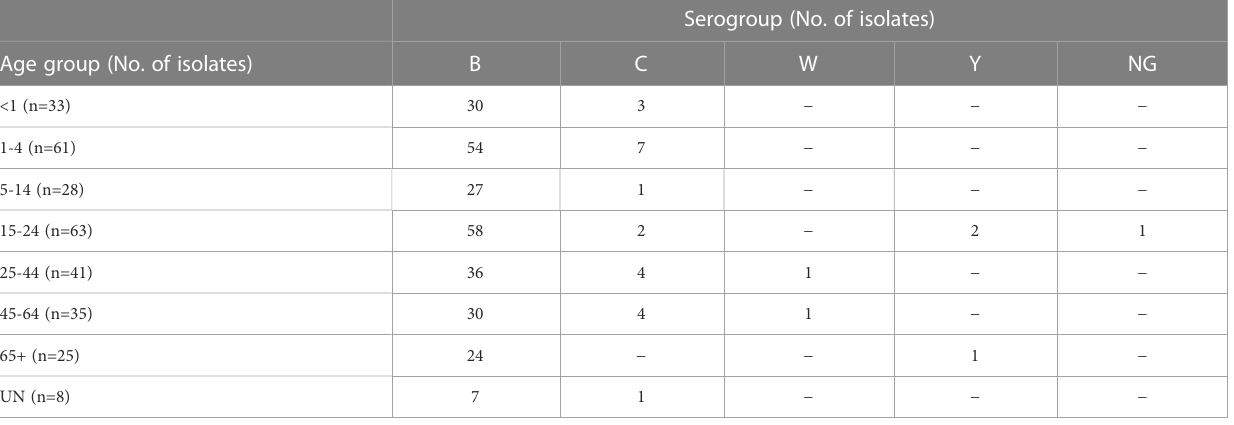
Serogroup (No. of isolates)